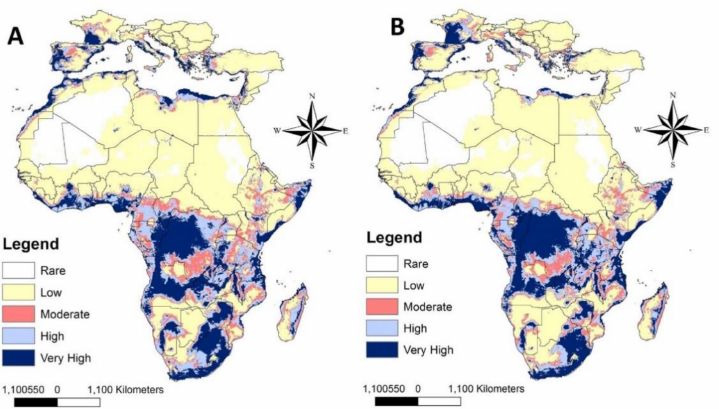
Figure 3. Predicted distribution of Oplostomus fuligineus in Africa and South Europe under future climate conditions in 2050; ( A ) for SSP 126, and ( B ) for SSP 585. SSP: Shared Socioeconomic Pathways.